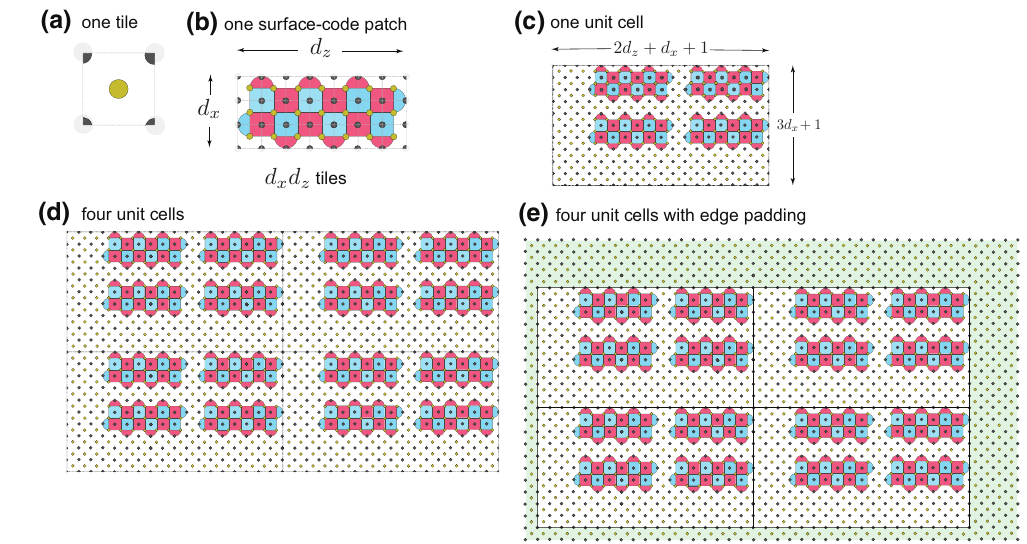
FIG. 14. The building blocks for a quantum computer. (a) A single tile containing two qubits: the ancilla qubits (cut at the four corners of the tile) are shared with neighboring tiles. (b) A single (asymmetric) surface-code patch. The number of tiles needed is the height times the width and so d x d z . (c) A single unit cell containing four surface-code patches and some routing space. Note that all surface-code patches have a X and Z logical boundary adjacent to either routing space within the bulk or the boundary of the unit cell. (d) Four unit cells tiled together. (e) The same as (d) but with the inclusion of extra padding highlighted in green at the edges to provide access to the remaining X and Z logical boundaries and ample routing space. There is more padding on the top and right since we need room to access the remaining X and Z logical operators. Fig. 14, every patch has logical X and Z boundary